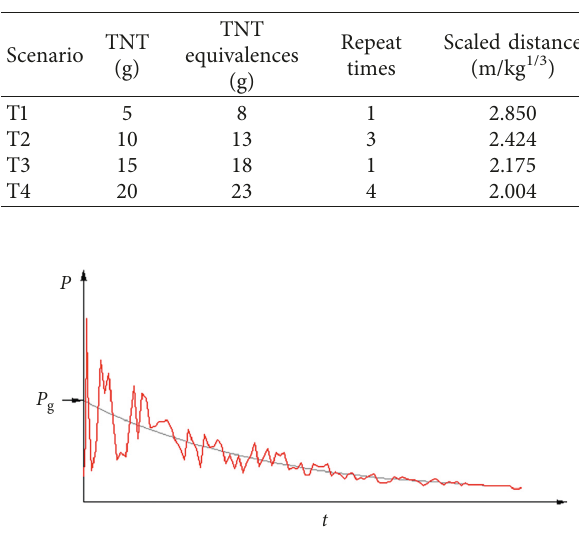
Table 1: Scheme of blast test of curved shell structure.